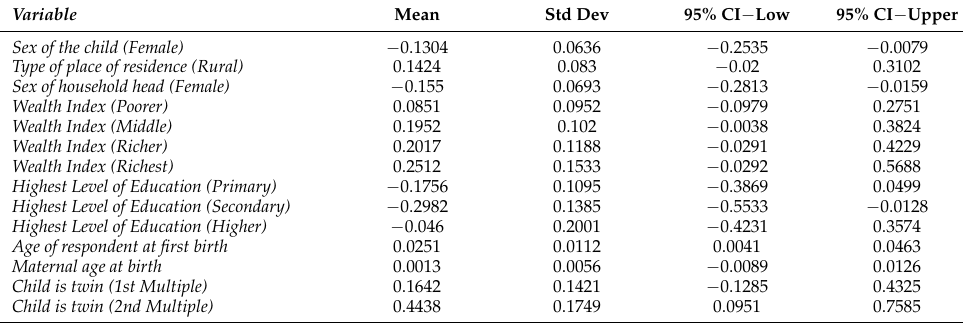
Table 3. Model summary regression